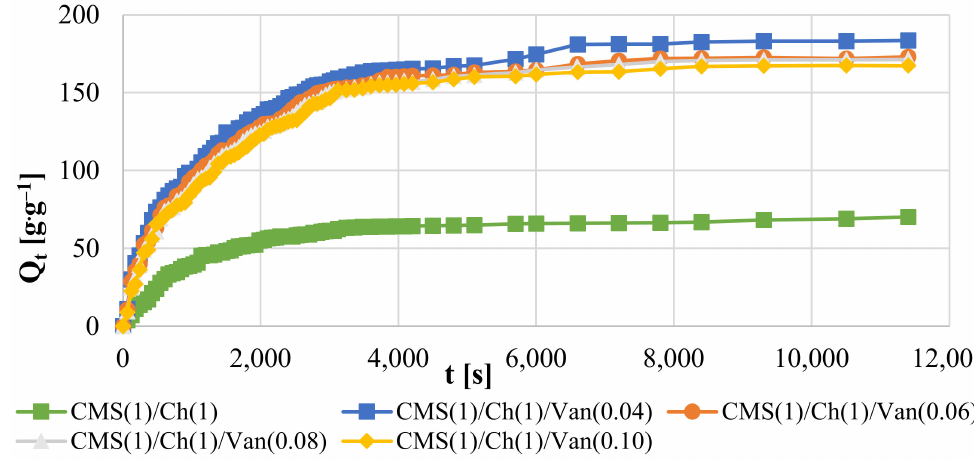
Figure 8. Swelling kinetic curves at 311 K. Table 5. Equilibrium swelling in the